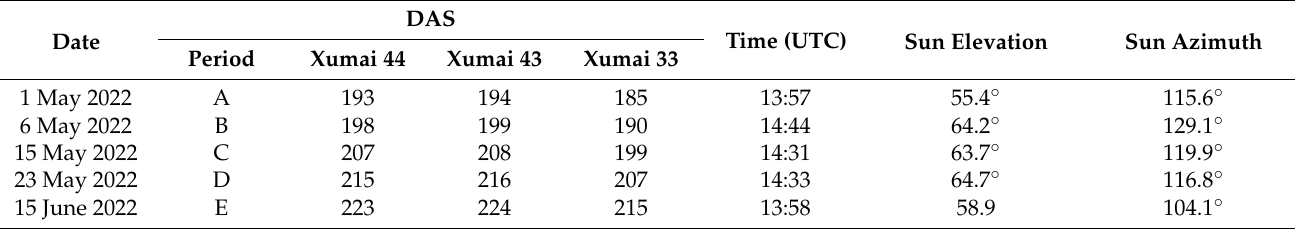
Table 1. Characteristics of PlanetScope satellite imageries (3 m resolution) on different dates of the grain-filling